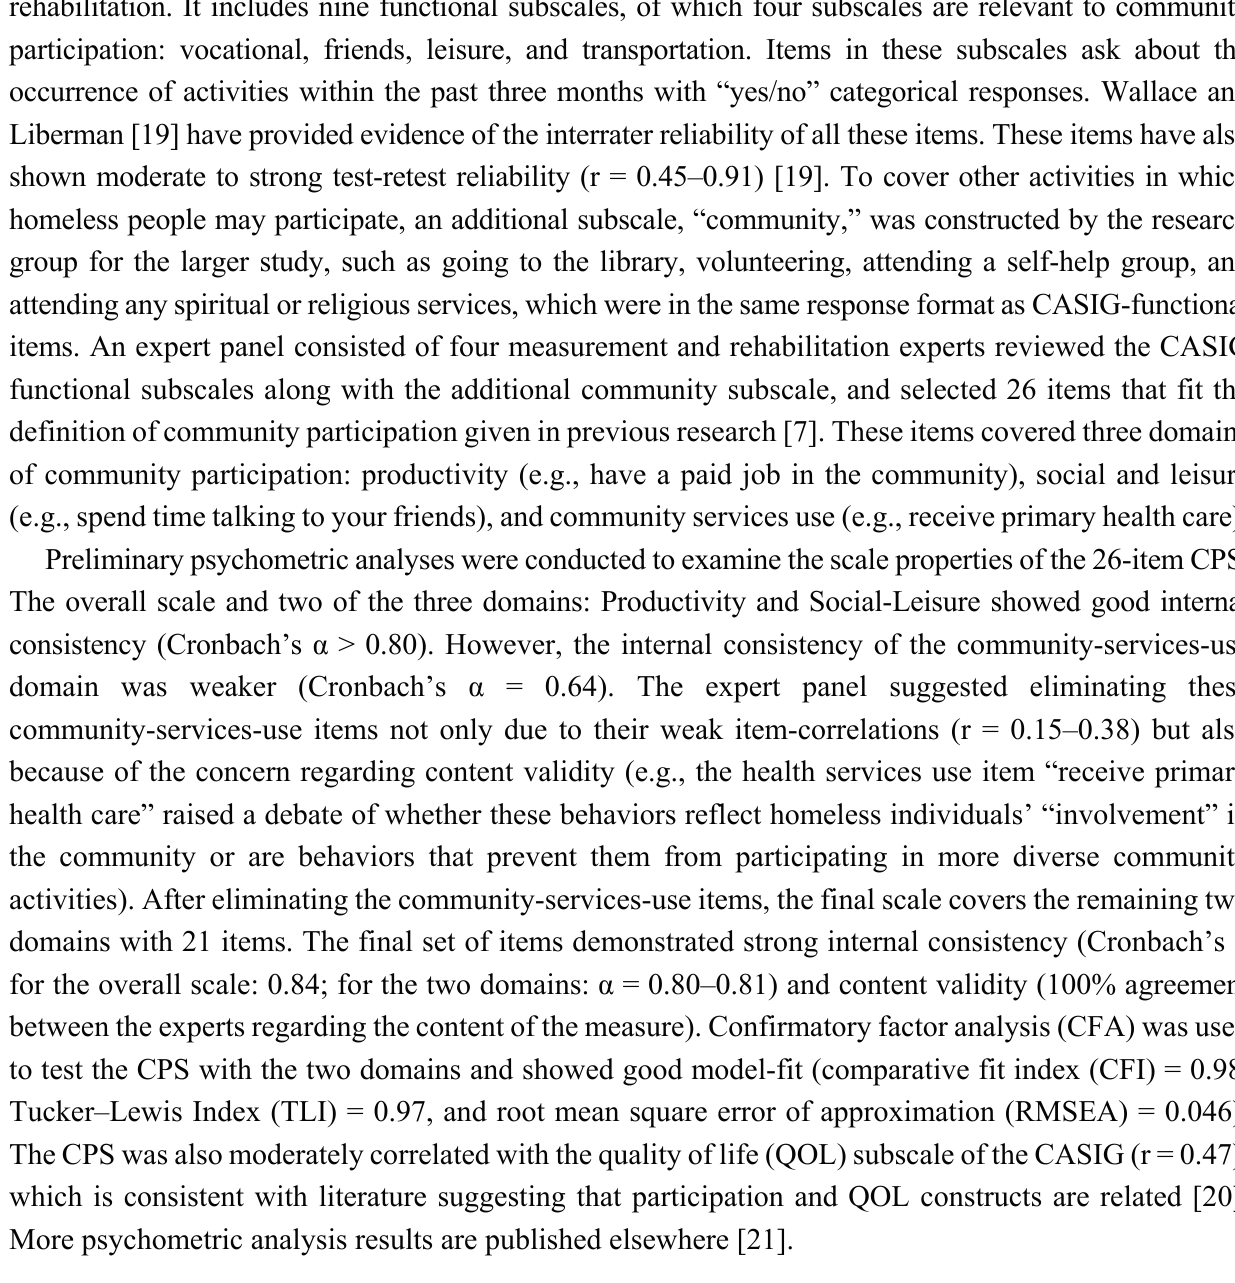
Figure 1. They included the following: psychiatric and physical symptoms, cognitive, physical, visual, hearing and speech functioning, demographics, homeless history, diagnosis, and housing